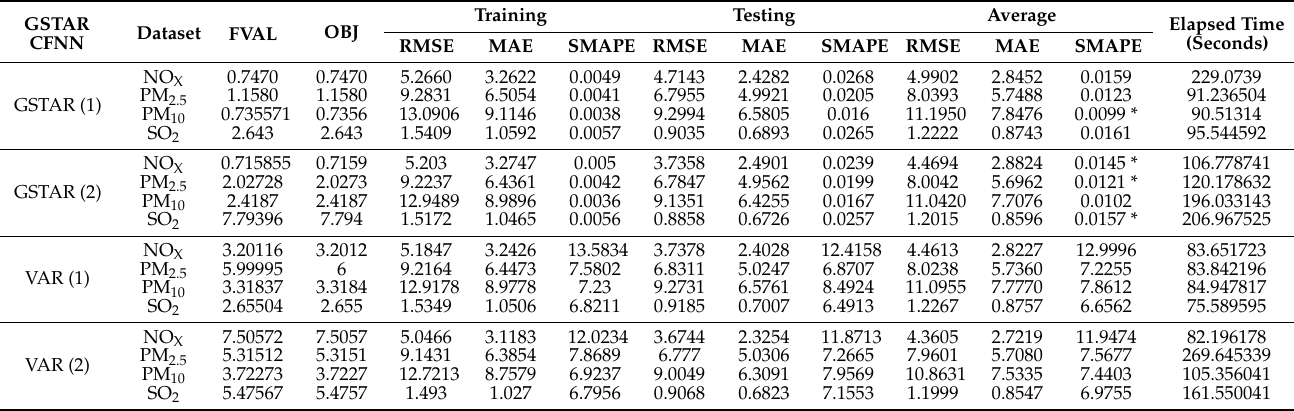
Table 1. Model Comparison based on